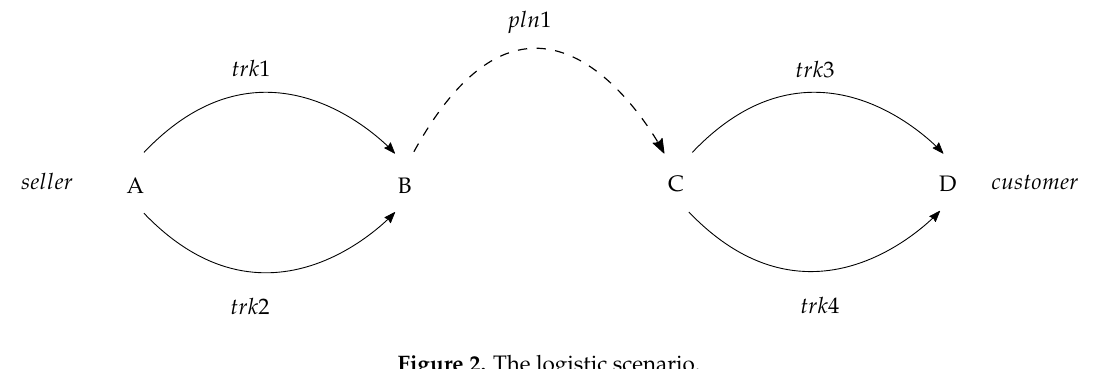
Figure 2. The logistic scenario.